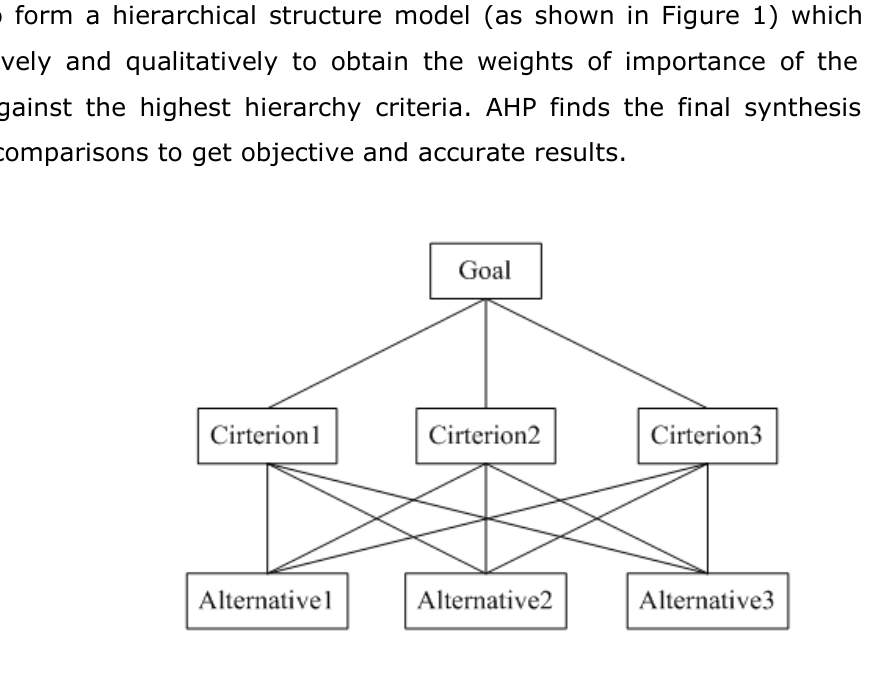
Figure 1. AHP hierarchical structure